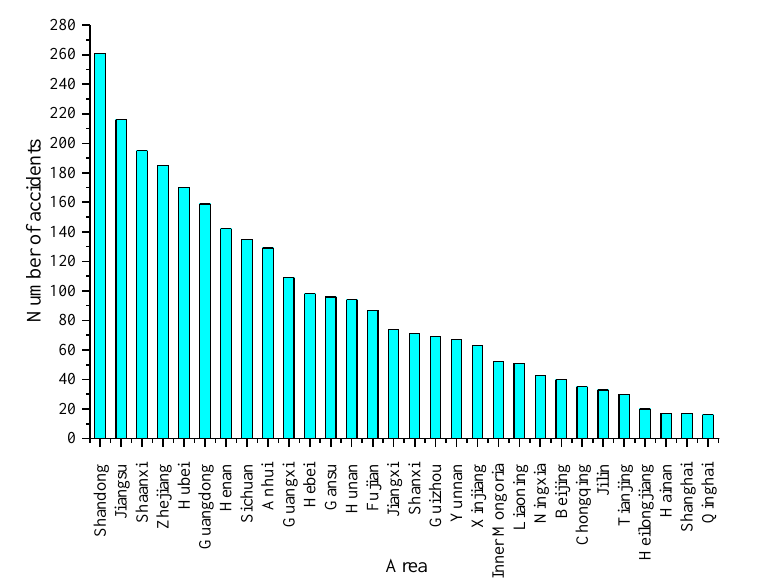
Figure 5. Distribution of accidents by the province of China.